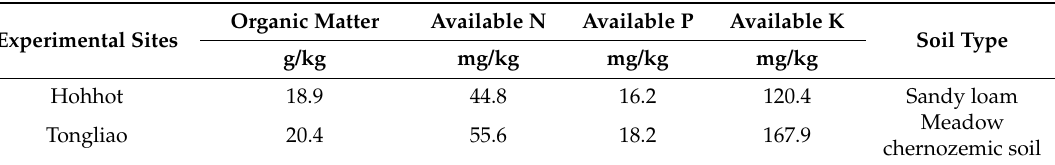
Table 3. Basis fertilizer of soil in Hohhot and